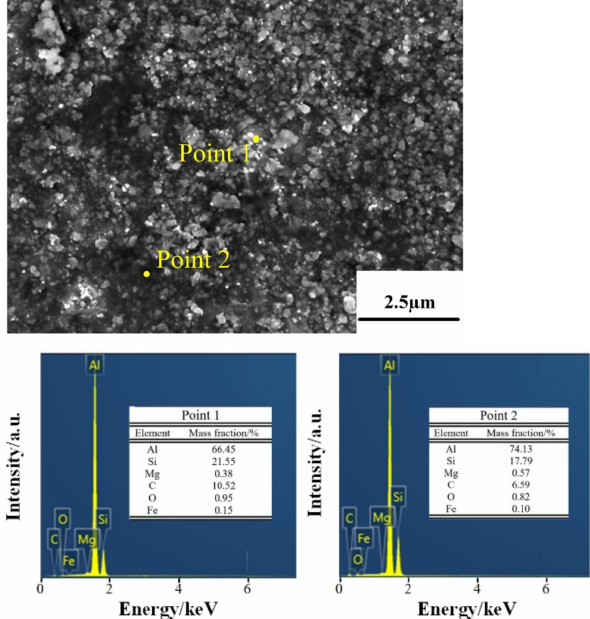
Figure 8. EDS results for the annealed